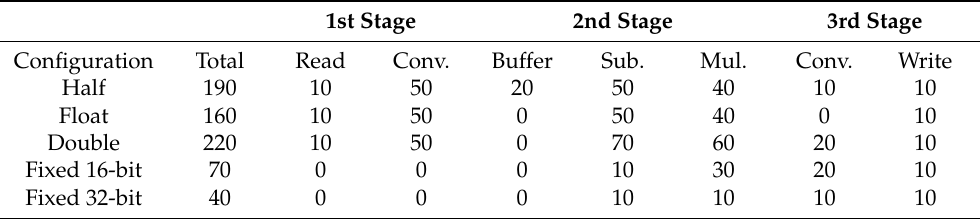
Table 5. Timing analysis of different data format configurations; all values are expressed in ns .